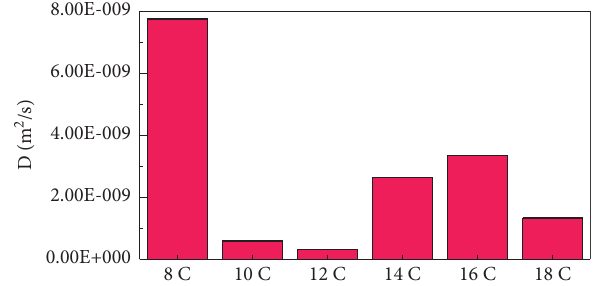
Figure 4: Diffusion coefficients of different